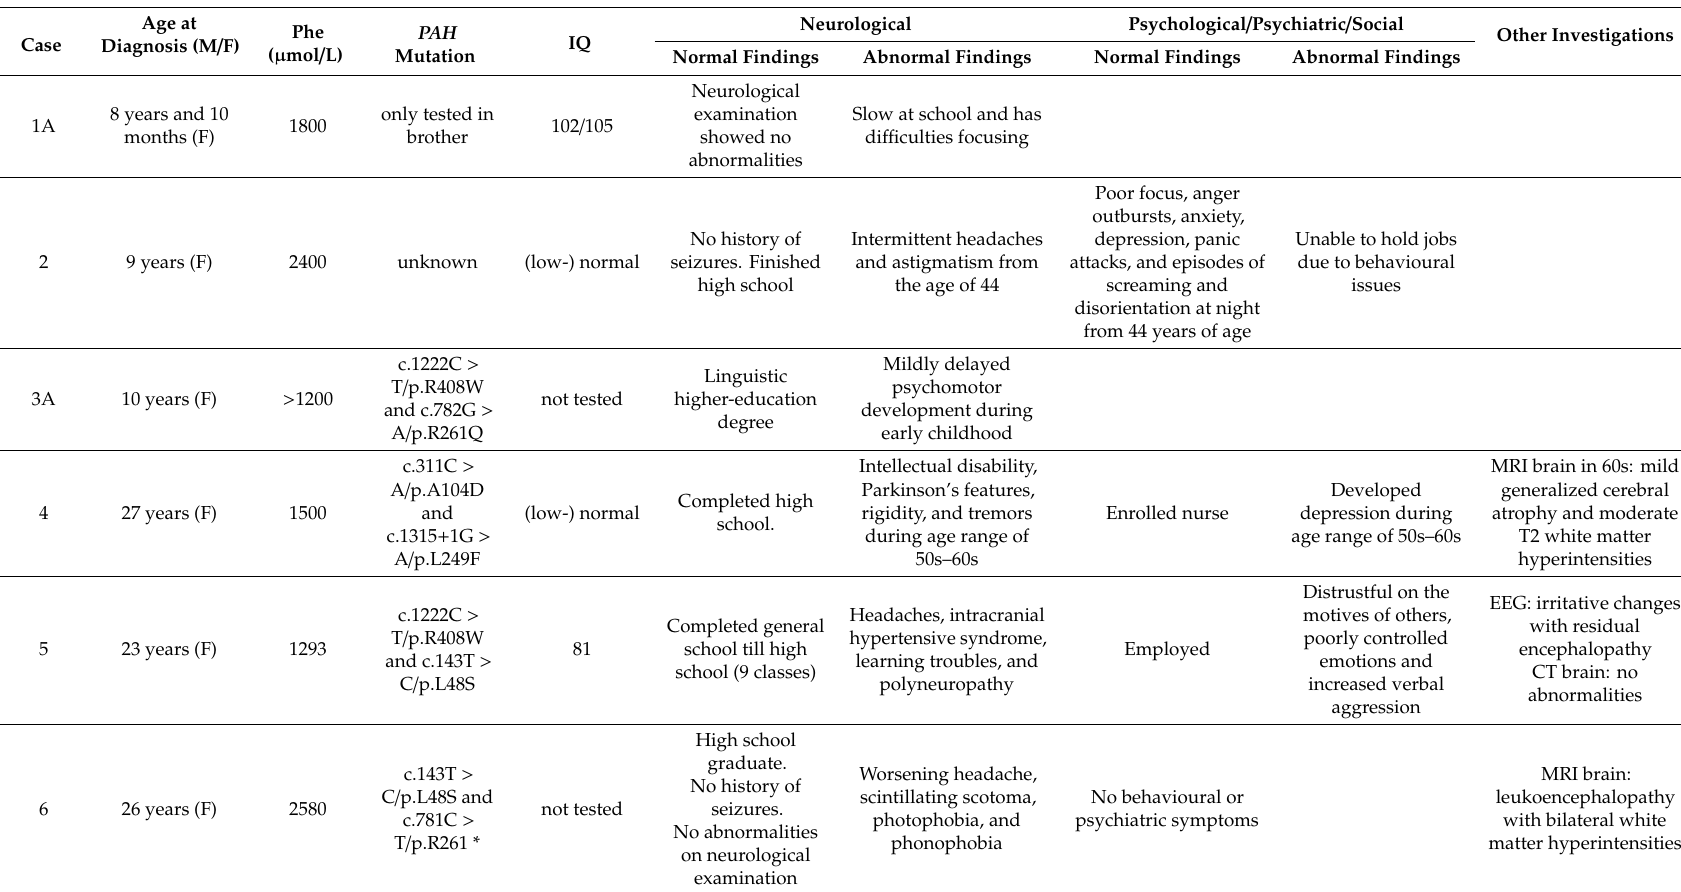
Table 1. Cases of late-diagnosed PKU patients who have escaped from intellectual disability despite high plasma Phe